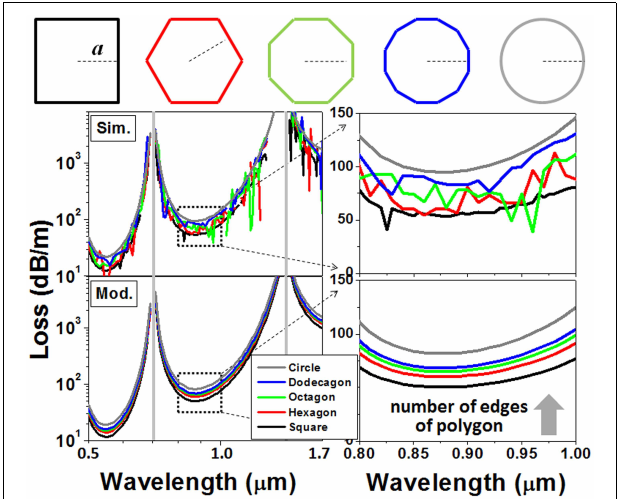
FIGURE 6 | Simulated and modeled attenuations of single-wall square (black), hexagon (red), octagon (green), dodecagon (blue), and circular (gray) fiber. a 9 . 76 µ m, t 0 . 67 µ m. = =